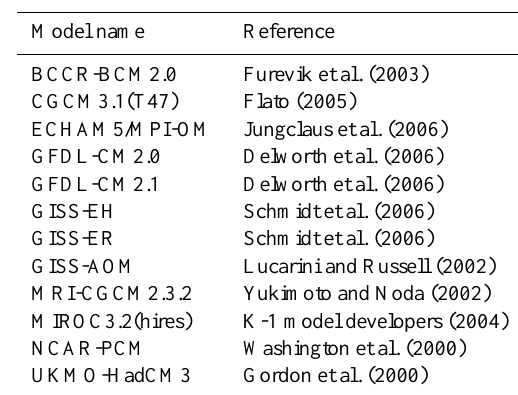
Table 2. CMIP3-Models used in this